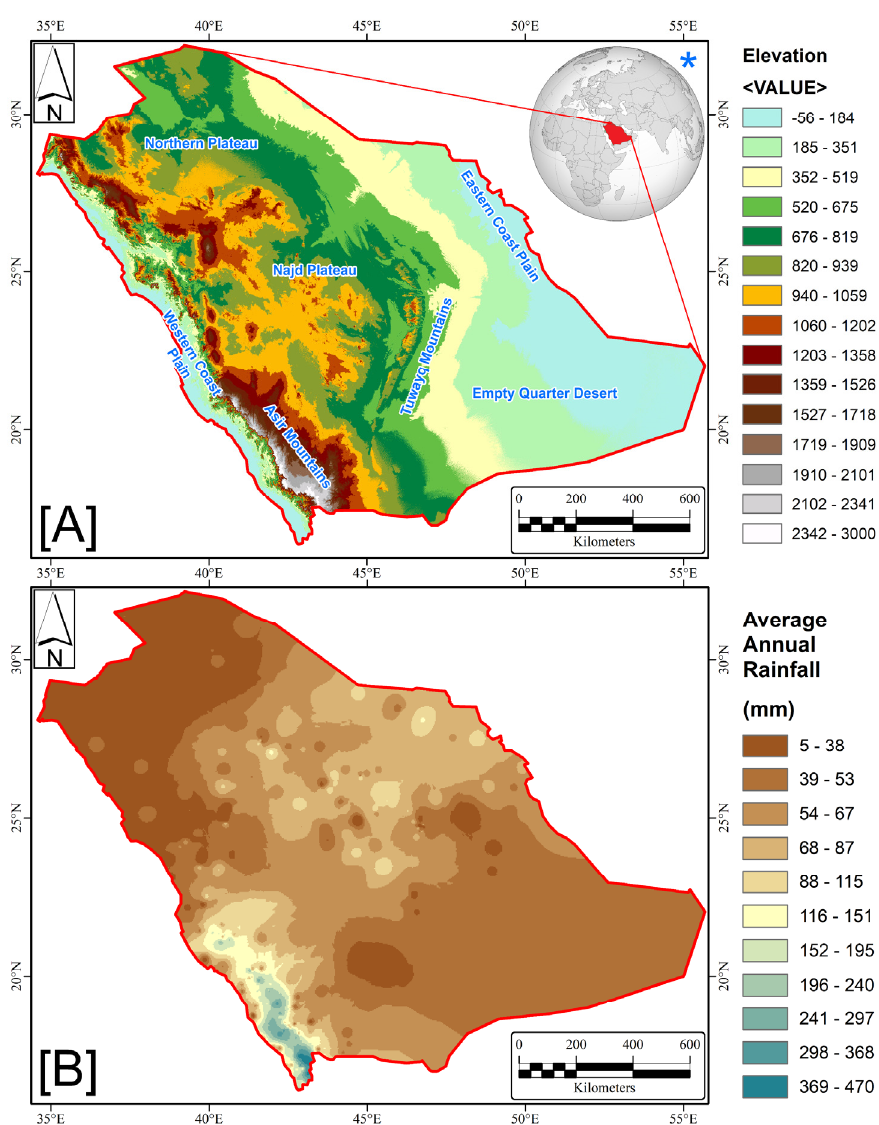
Figure 1. ( A ) Location and topography of the Kingdom of Saudi Arabia, ( B ) average annual precipitation (* https://en.wikipedia.org/wiki/Saudi_Arabia#/media/File:Saudi_Arabia_(orthographic_projection).svg), accessed on 5 January 2022.